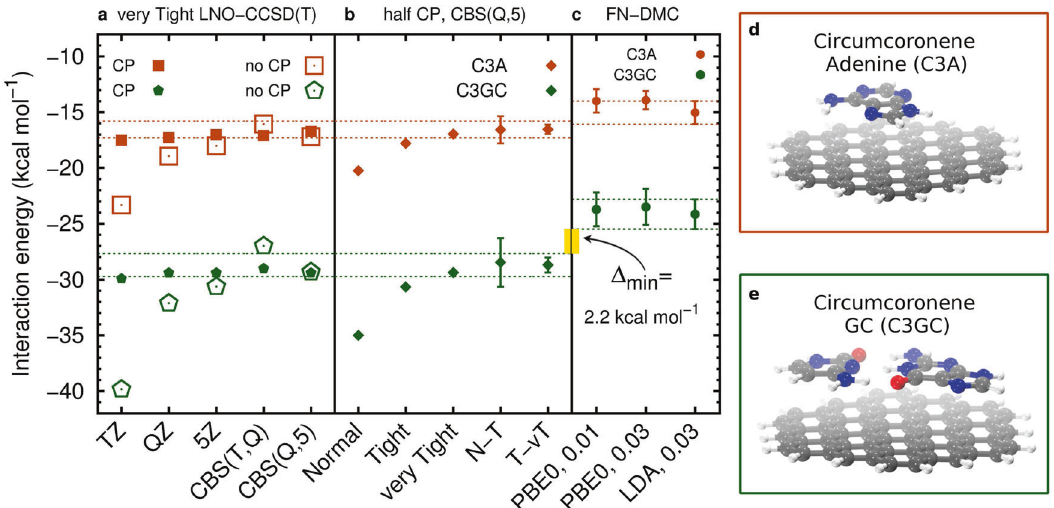
Fig. 4 The interaction energy of the C3A and C3GC complexes using different settings. LNO-CCSD(T) shown in ( a and b ), and FN-DMC in ( c ). The orange and green dashed horizontal lines, for C3A and C3GC, respectively, enclose the best estimated CCSD(T) ( a and b ) and the fi nal FN-DMC ( c ) interaction energies using the corresponding uncertainty estimates and stochastic error bars. The FN-DMC error bars indicate 95% con fi dence intervals. The yellow bar denotes the minimum difference between CCSD(T) and FN-DMC ( Δ min ). a CP-corrected and uncorrected LNO-CCSD(T) interaction energies using the aug-cc-pV X Z basis sets, as well as CBS( X , X + 1) extrapolation. b Convergence of half CP-corrected LNO-CCSD(T)/CBS(Q,5) interaction energies using a series of LNO thresholds as well as Normal--Tight (N – T) and Tight--very Tight (T-vT) extrapolations. c FN-DMC interaction energies with two nodal surfaces or C3GC from DFT (PBE0 and LDA) and different time-steps (given in a.u.) for C3A and C3GC. d C3A complex. e C3GC